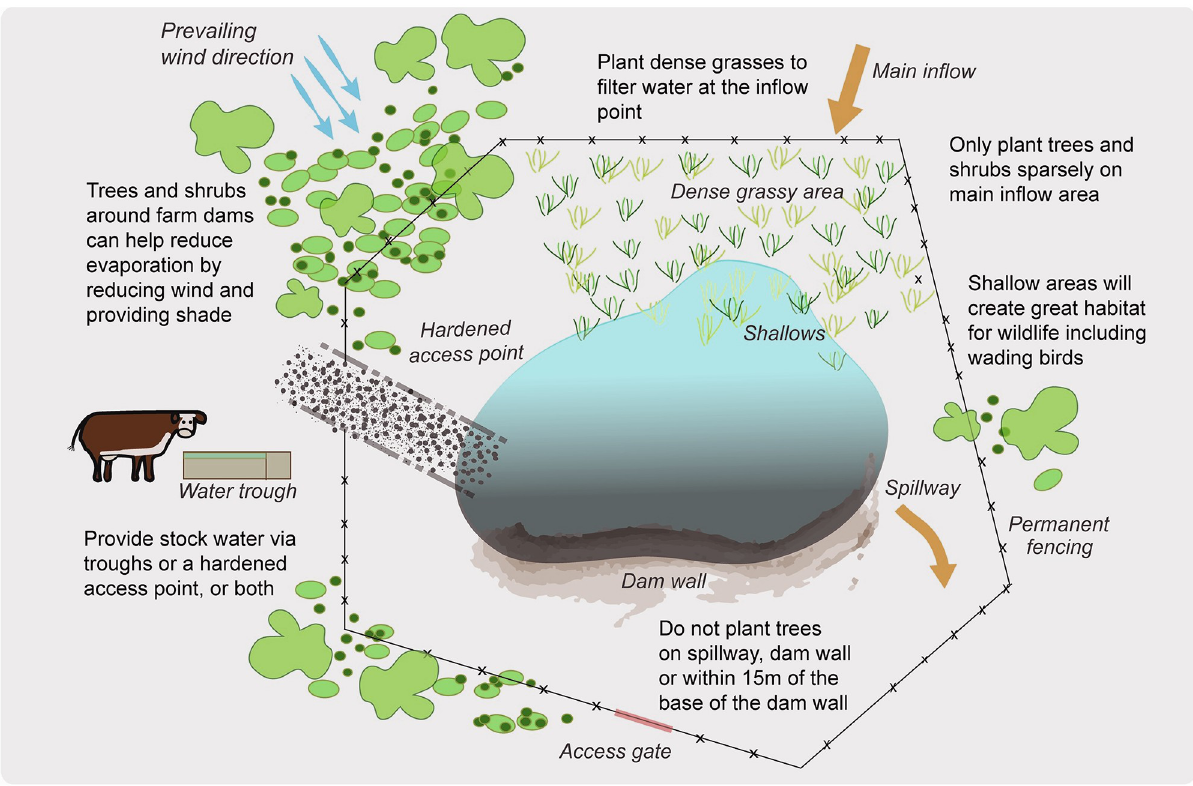
Fig 1. Management interventions aimed at improving water quality in farm dams in south-eastern Australia (http://www.sustainablefarms.org. au/research).